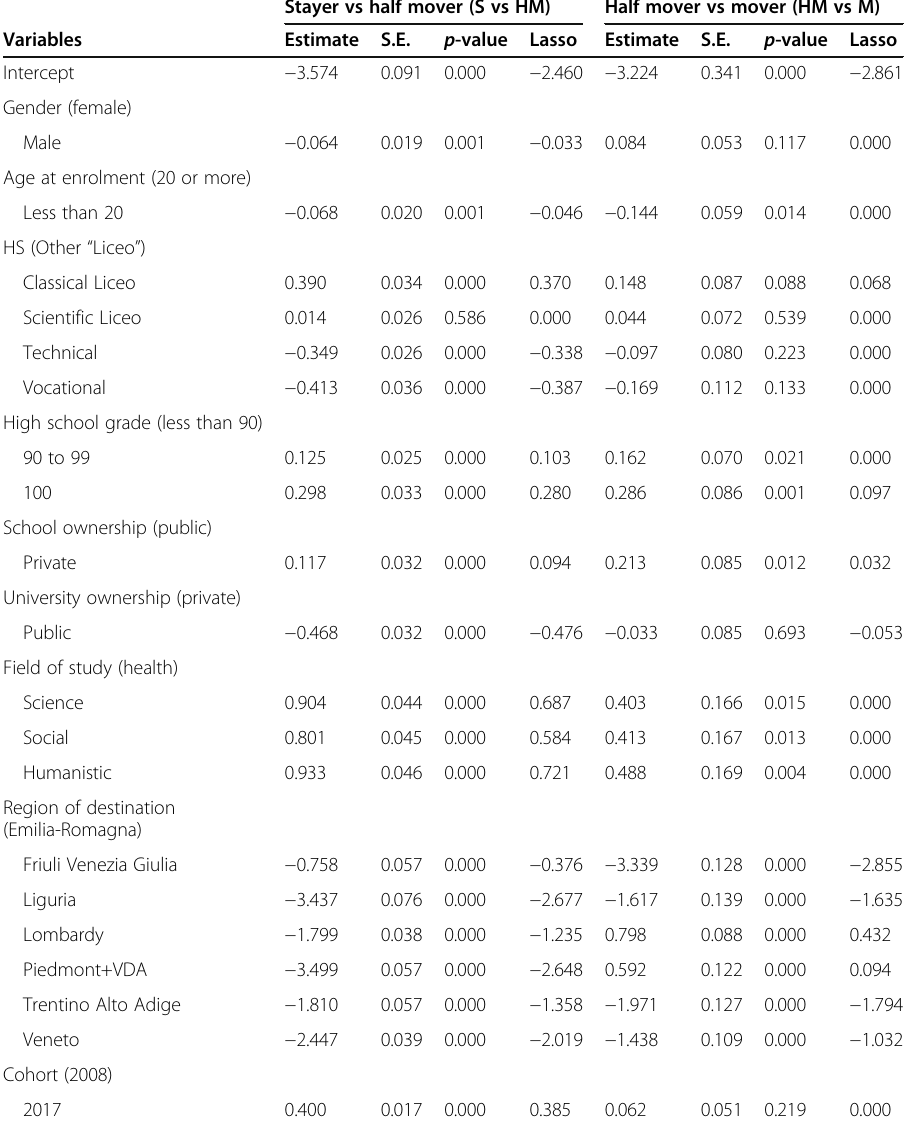
Table 5 Regression model. Results of the ordinal logit model and Lasso (with effects of region of destination and province of residence – summarised in the “ Conclusions ”